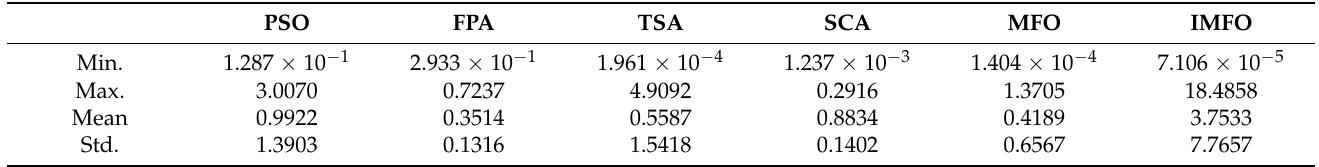
Table 5. Statistical analysis for all